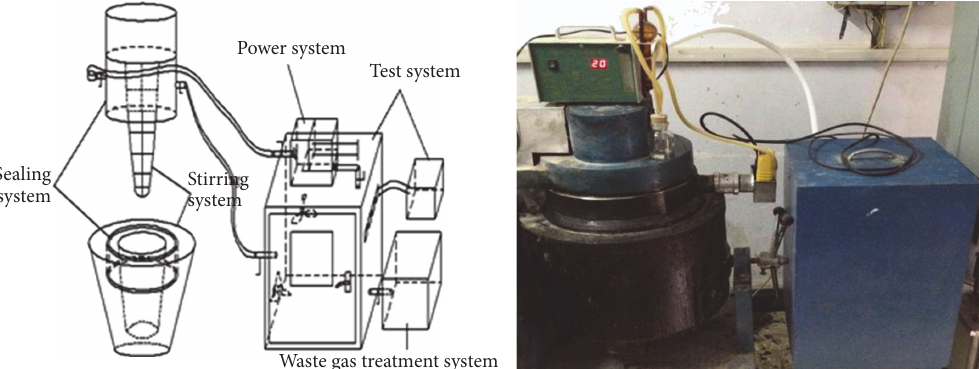
Figure 1: Test equipment for pollutant emission.